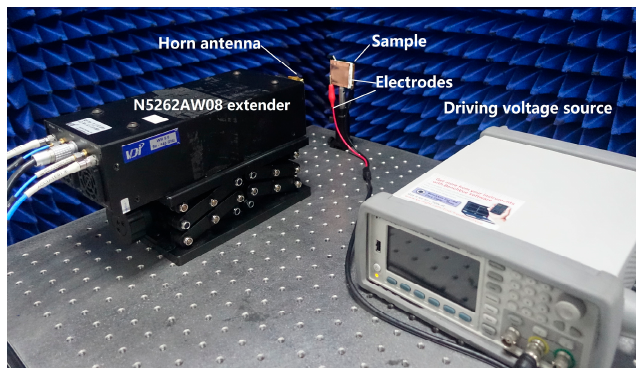
Figure 7. Measurement setup of the reflectarray.